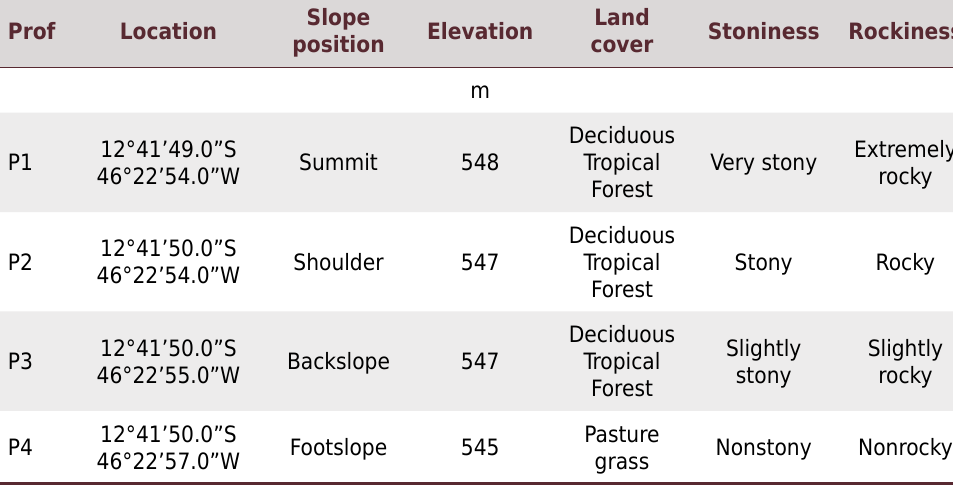
Table 1. Overall description of soil profiles (Prof) in the toposequence in Lavandeira, TO, Brazil